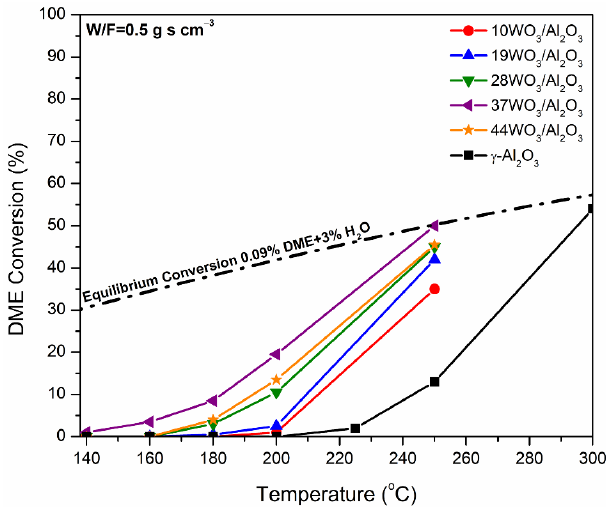
Figure 7. Conversion of DME to CH 3 OH as a function of reaction temperature over WO 3 /Al 2 O 3 cat- alysts. The equilibrium conversion is also included. Reaction conditions: 0.09% DME, 3% H 2 O, W/F = 0.5 g s cm −3 .